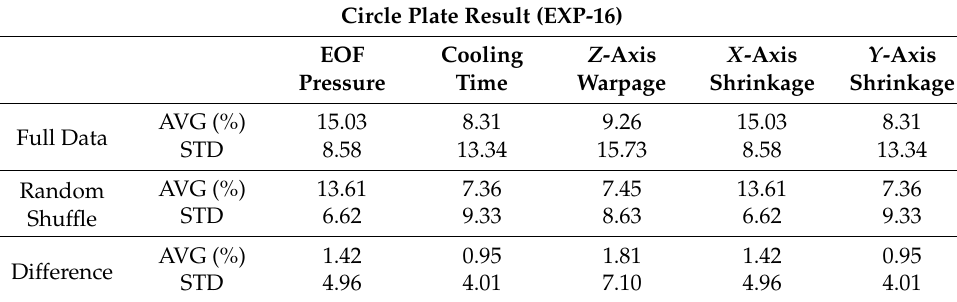
Table 22. Training results for the round flat model (EXP-16).